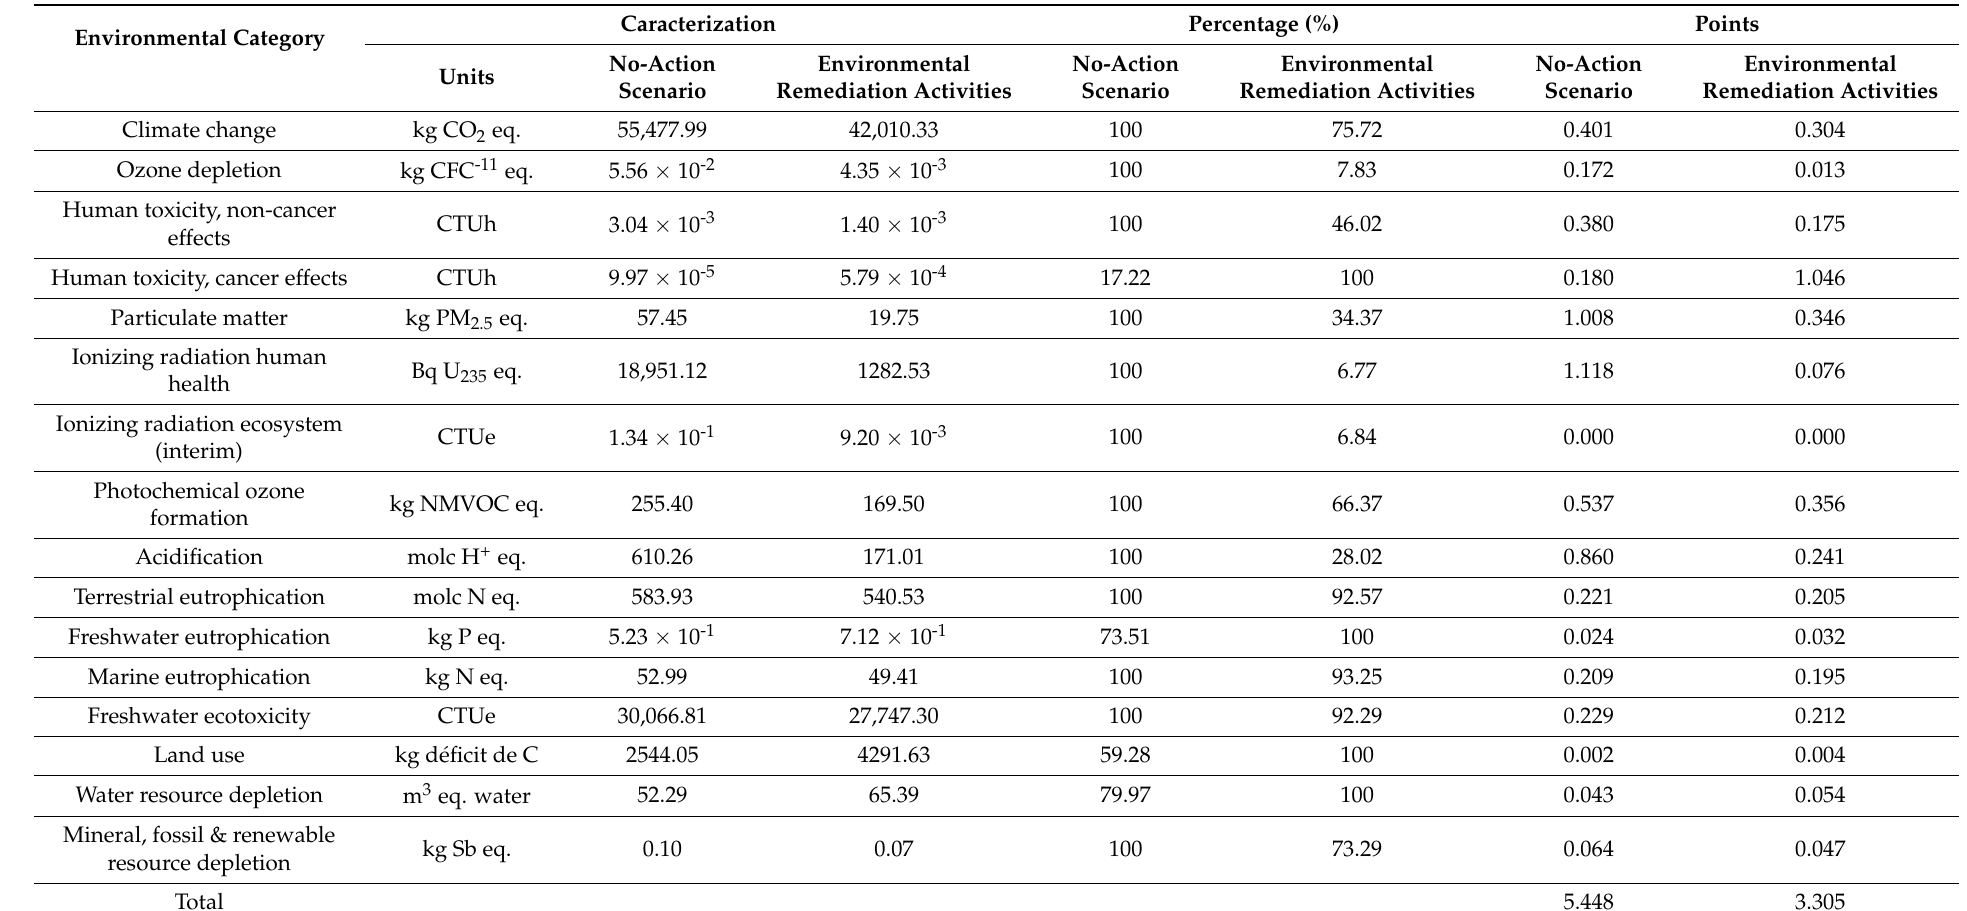
Table 3. Results of LCA for the no-action and remediation scenarios in the characterization